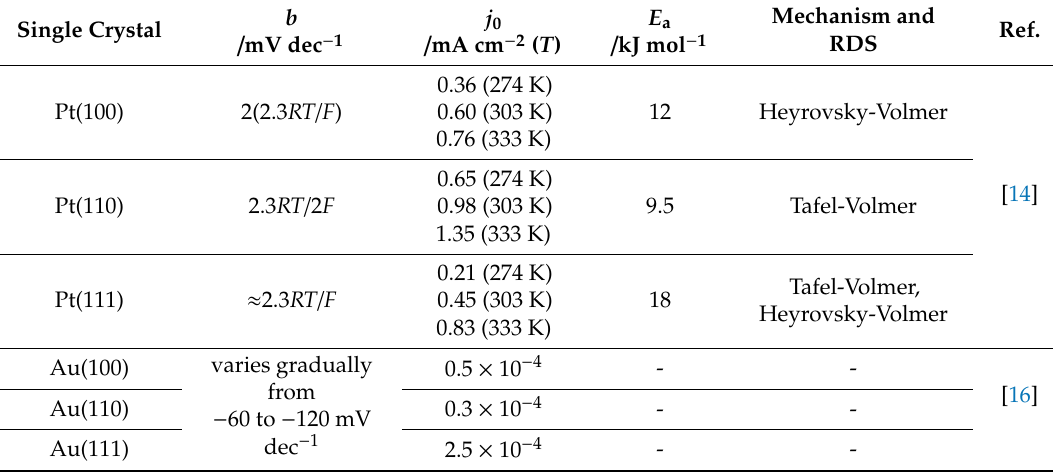
Table 1. Hydrogen evolution reaction (HER) on pure metal single crystal surfaces, in acid solutions, and the corresponding available data: Tafel slopes ( b ), exchange current densities ( j 0 ) at given temperatures ( T ), activation energies ( E a ), and identified mechanism and rate-determining step (RDS). Mechanism and b j 0 E a Single Crystal Ref. / mV dec − 1 / mA cm − 2 ( T ) / kJ mol − 1 RDS Pt(100) 2(2.3 RT / F